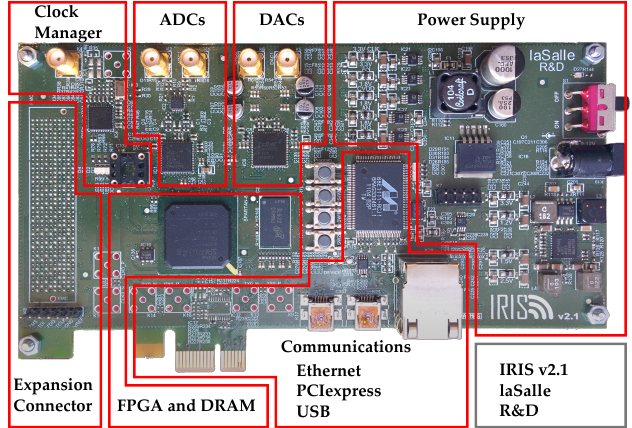
Figure 7. Picture of the IRIS platform and the functional